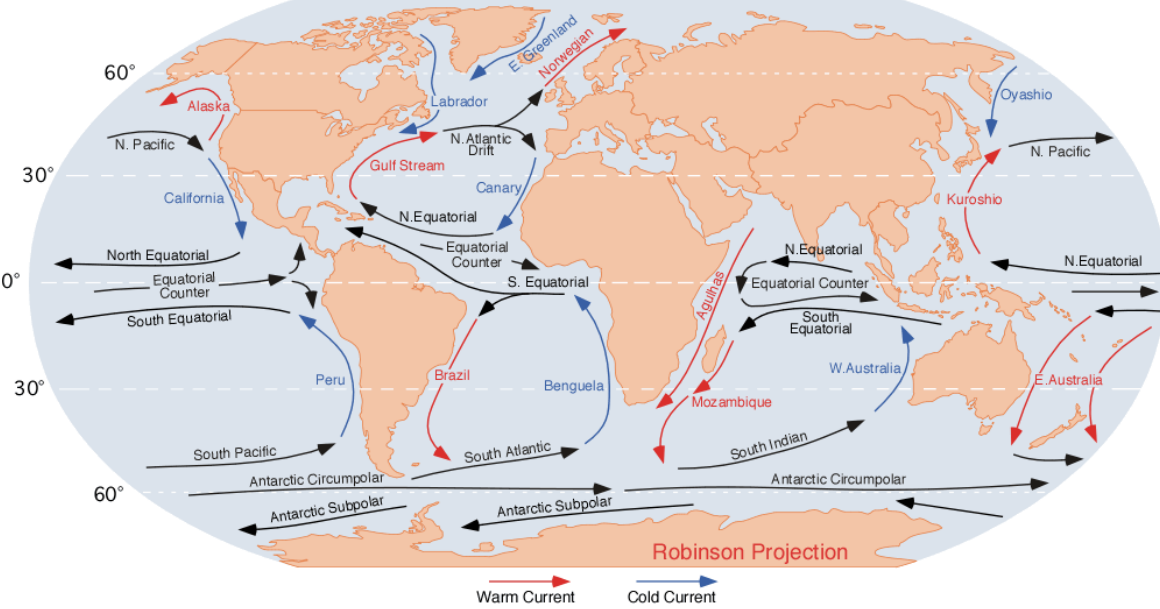
Figure 3. The global ocean currents, including warm currents (red line), cold currents (blue line), and neutral current (black line) adopted from https://commons.wikimedia.org/wiki/File:Corrientes- oceanicas.png (accessed on 8 October 2022).